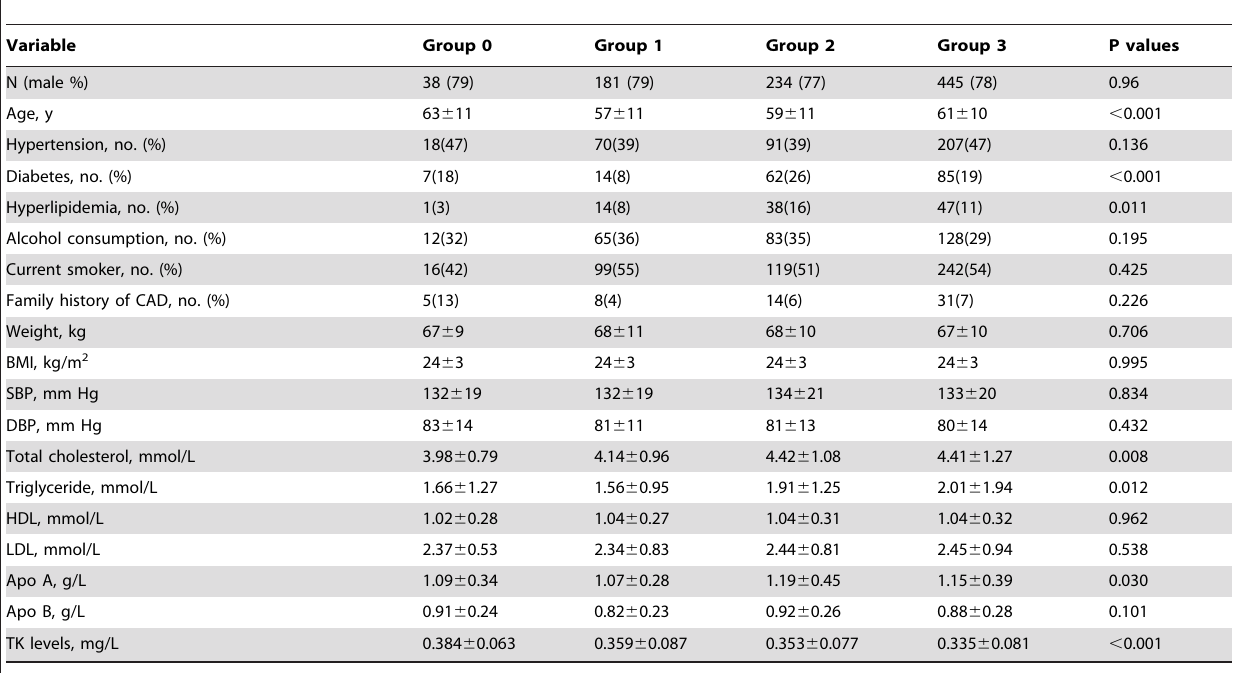
Table 4. The relationships between vessel scores and general characteristic of CAD patients.